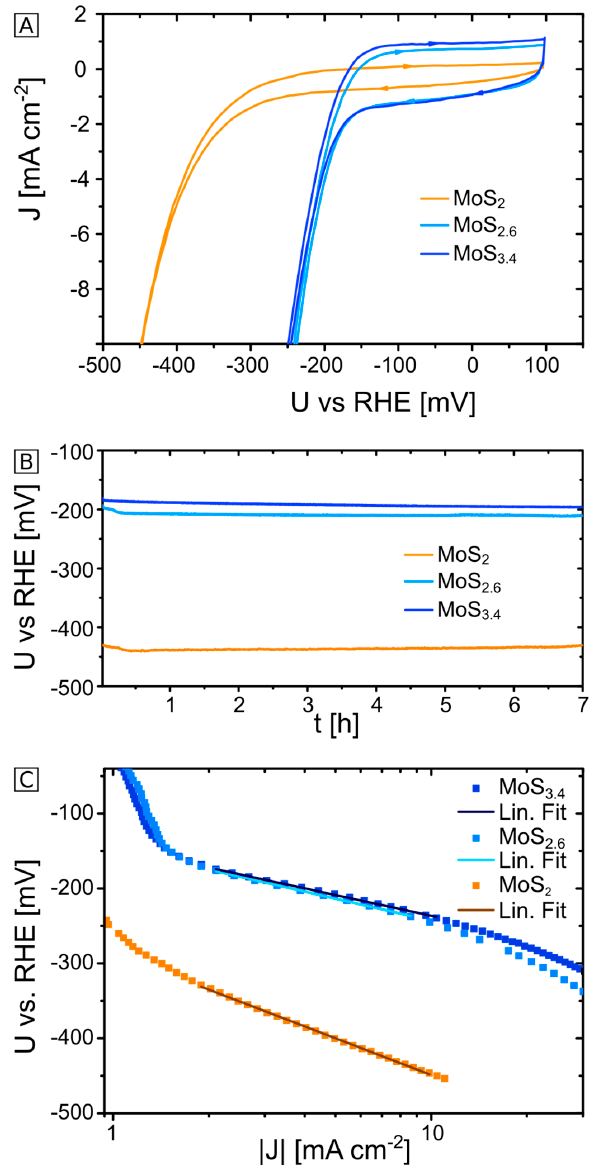
Figure 1. Electrochemical measurements for the two MoS x and MoS 2 (immobilized on graphite) in sulfuric acid (0.5 M , pH 0.3). ( A ): cyclic voltammetry (cycle 6, scan rate 20 mV s − 1 ); ( B ): chronopotentiometry at a current density of 3 mA cm − 2 , the first 2 min are cut o ff ; ( C ): Tafel analysis. See materials and methods for experimental